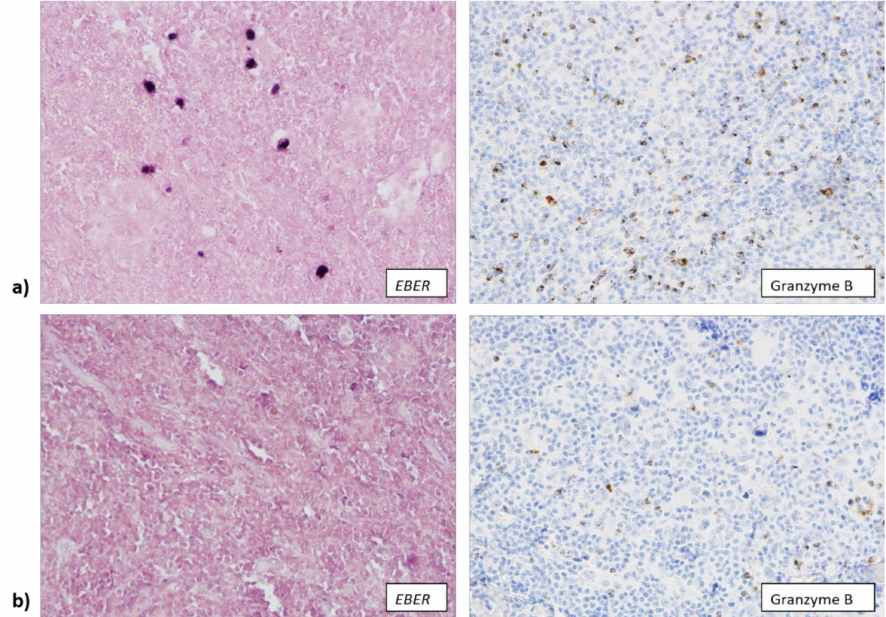
Figure 1. ( a ) Tissue samples in which EBER (Epstein-Barr encoding RNA) mRNA was detected (400 × total magnification) contained a larger number of cells expressing granzyme B (400 × total magnification). ( b ) The number of granzyme B+ cells (400 × total magnification) was